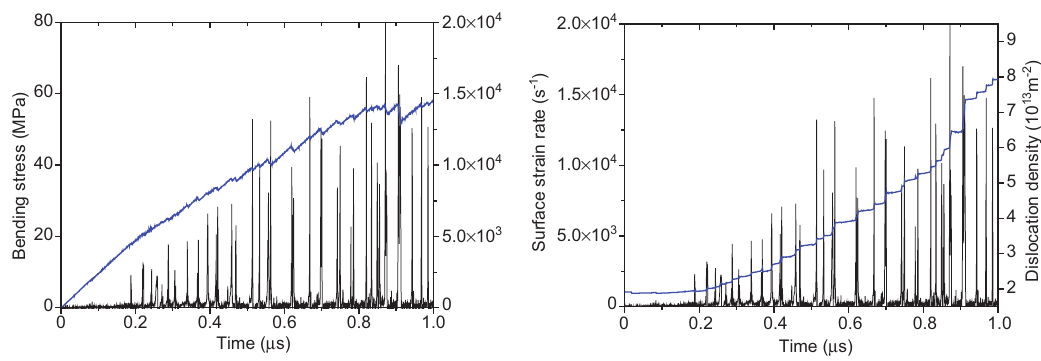
Figure 8 Stress, strain rate, and dislocation density vs. time signals in a DDD simulation of microbending. Left, Scaled bending moment vs. time and plastic surface strain rate vs. time; right, dislocation density vs. time and plastic surface strain rate vs.